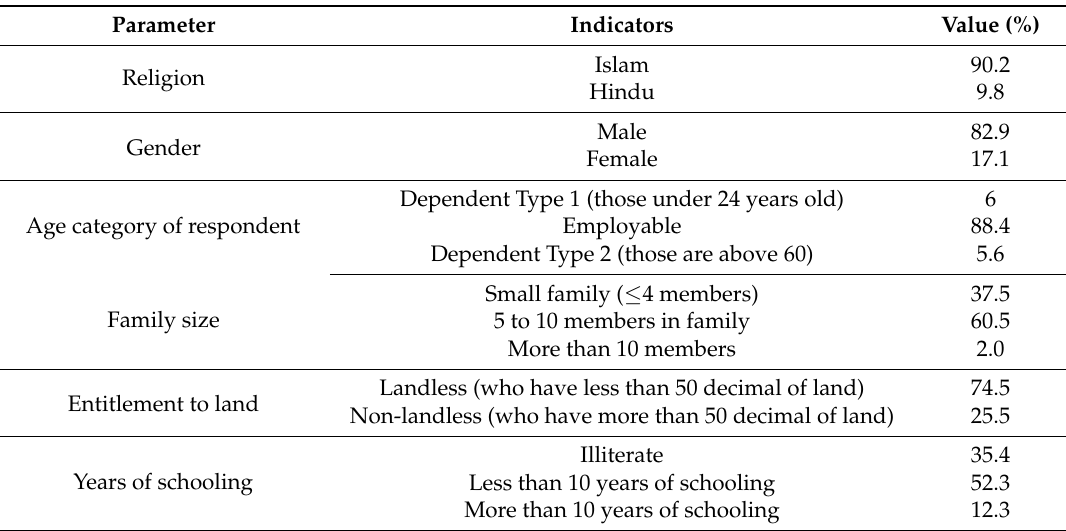
Table 2. Socio-demographic statistics of the respondents.